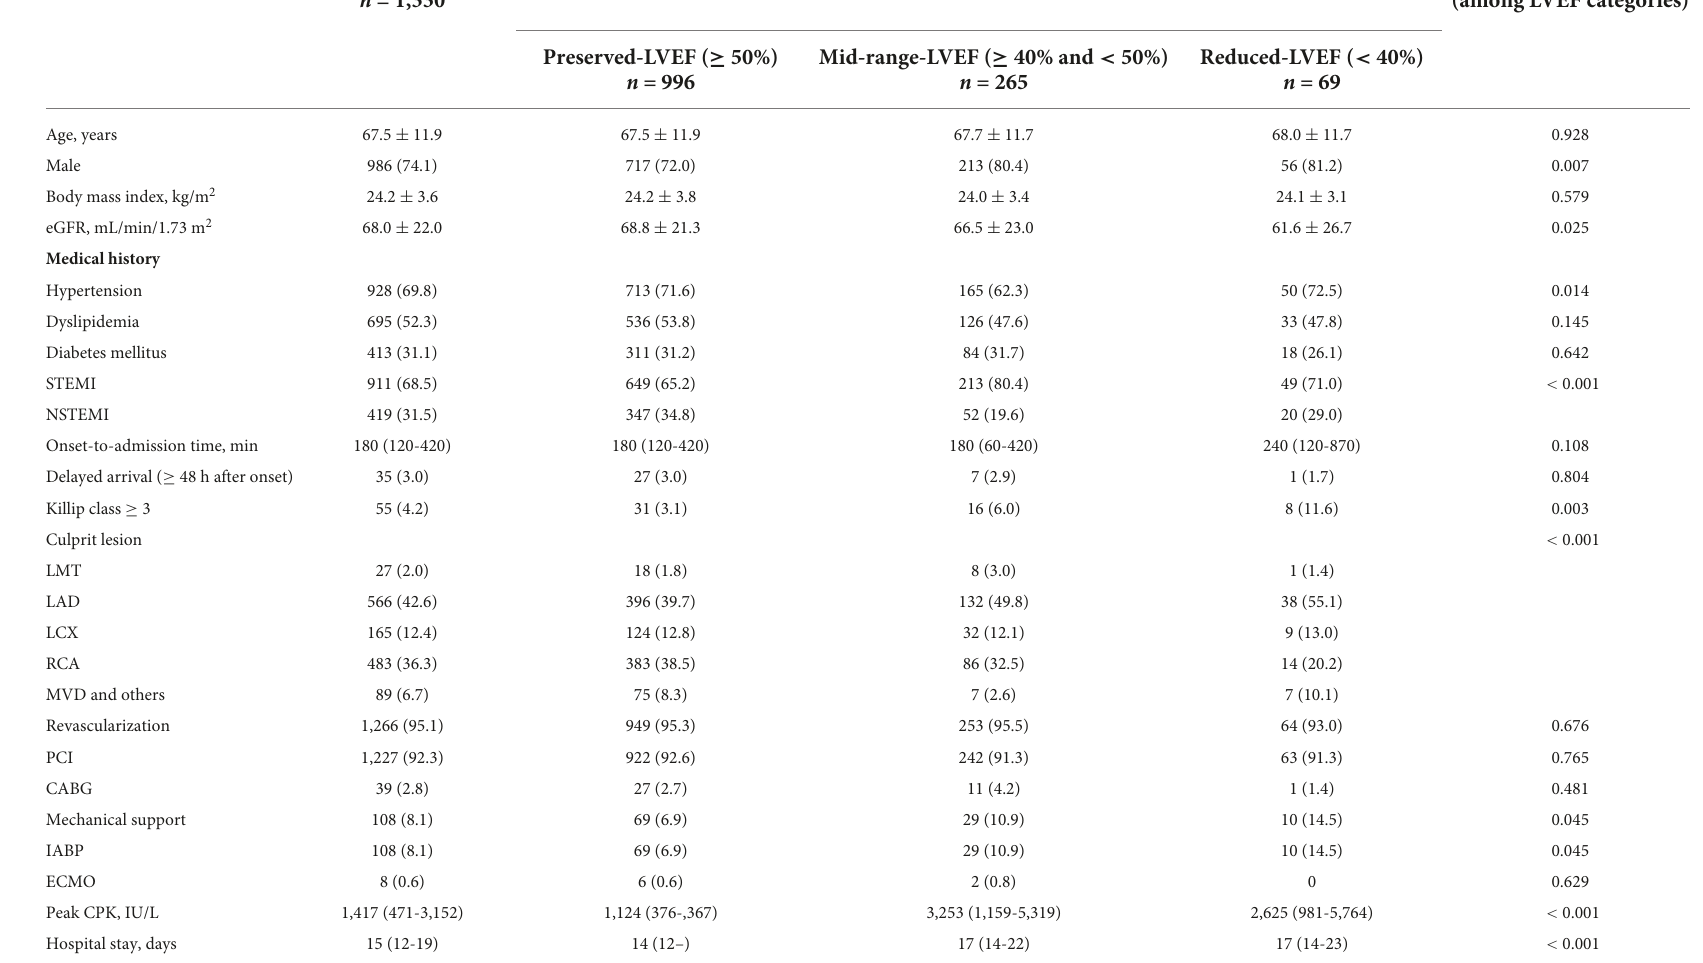
TABLE 1 Patient background characteristics, procedural information, and medications at discharge.